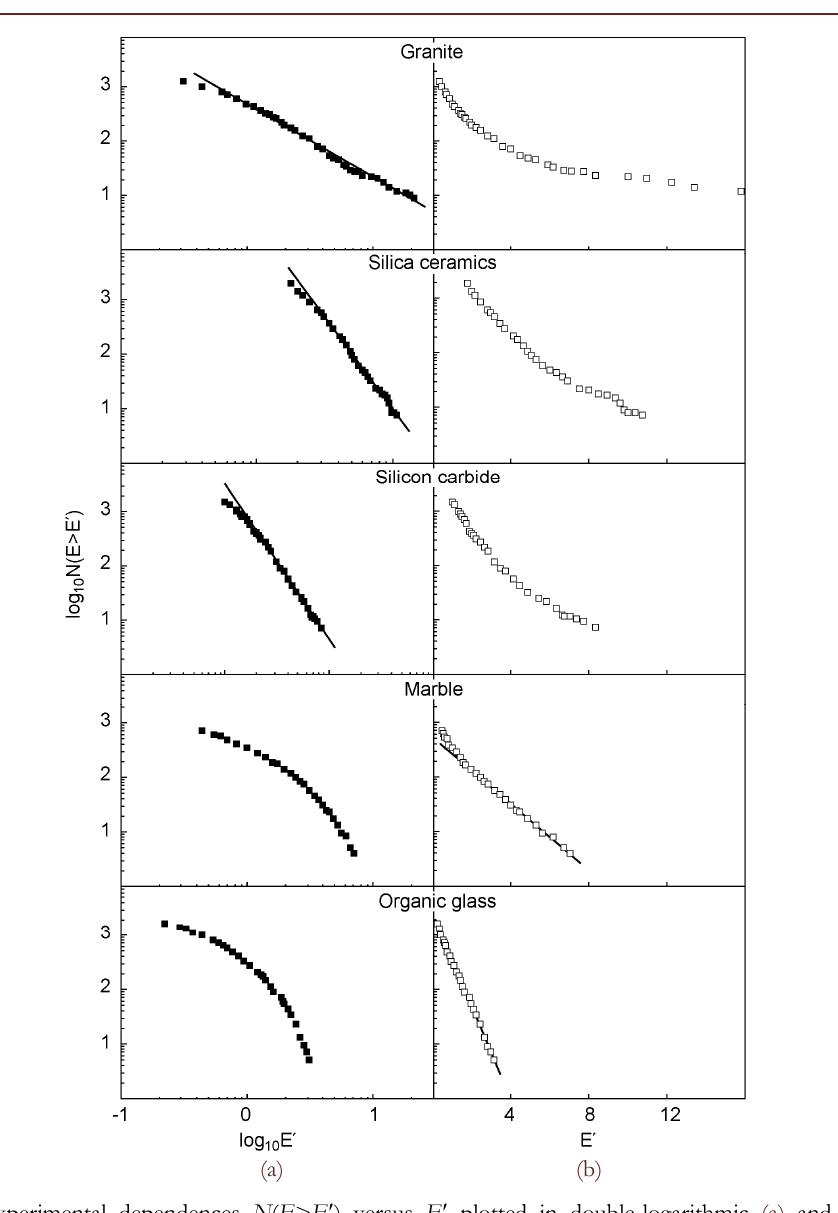
Figure 3: The same experimental dependences N ( E > E  ) versus E  plotted in double-logarithmic (a) and semi-logarithmic (b) coordinates; straight lines in (a) and (b) fit Eq. (1) and Eq. (2),